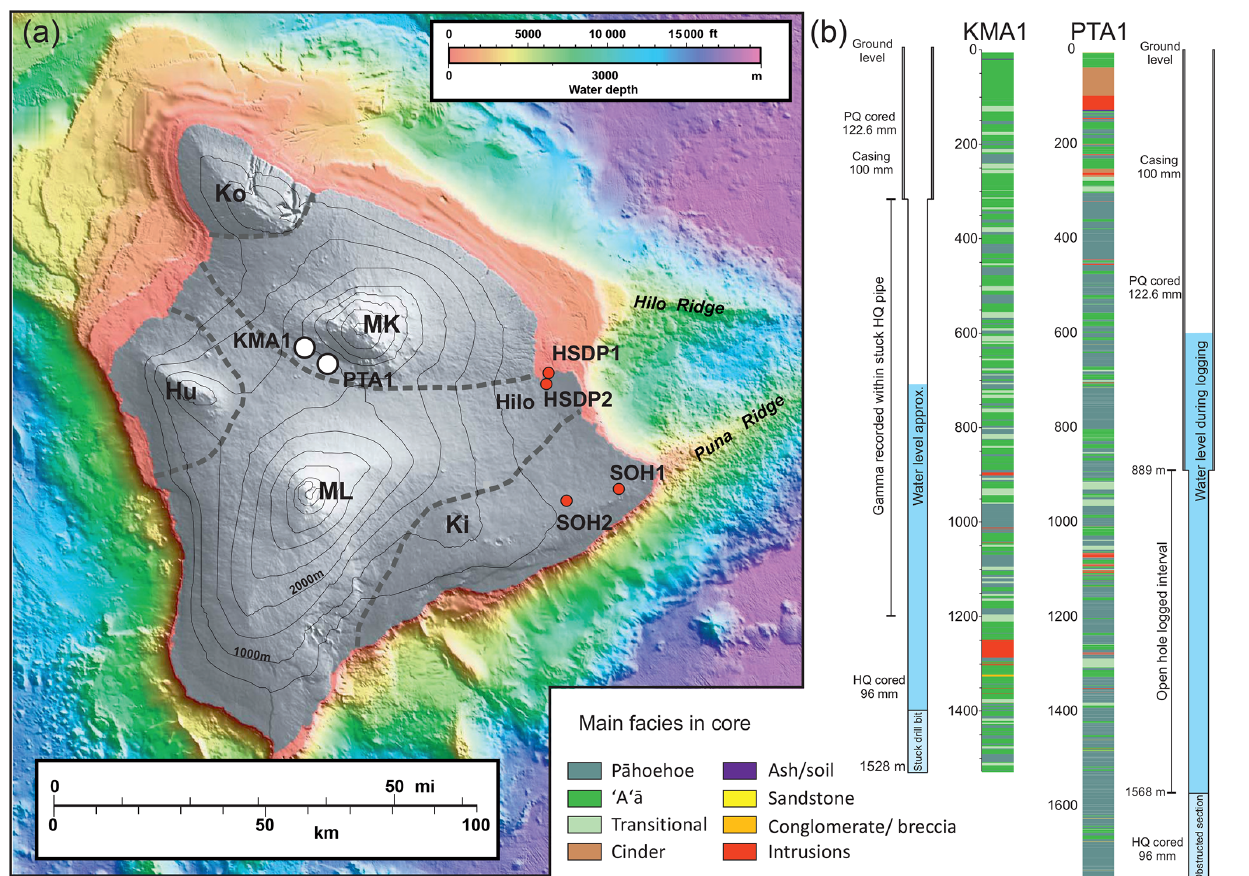
Figure 1. (a) Location map of the PTA2 and KMA1 boreholes on a topographic and bathymetric map of Hawai‘i (bathymetric map from USGS, Eakins et al., 2003). Locations of a selection of additional cored boreholes drilled on Hawai‘i are also indicated (red dots) (SOH4 1989, 2.0km; SOH1 1991, 1.7km; HSDP1 1993, 1.1km; HSDP2 1999, 3.1km) (see also Garcia et al., 2007) (MK – Mauna Kea, ML – Mauna Loa, KI – Kilauea, HU – Hual¯alai, Ko – Kohala). (b) The cored sections of PTA2 and KMA1 are indicated with their